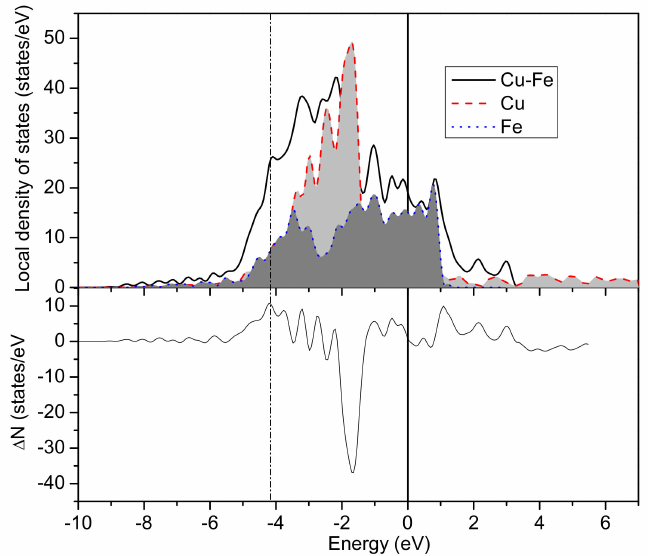
Figure 4. The LDOS of the binary Cu-Fe system, the Fermi energy is set to 0 eV. ∆ N is the di ff erence between the LDOS of Cu / γ –Fe system and that of Cu(100) system and Fe(100) system. For ternary alloy, Cu-Fe-Ag(Si) were taken as an example; the Fe-Cu bonding and antibonding states were determined by the di ff erence ∆ N between the LDOS of the Cu-Ag(Si) / γ –Fe system and that of the Cu-Ag(Si) (100) system and Fe(100) system. The Cu-Ag / γ –Fe interface list in Figure 5 shows that the bonding states were around − 5.45~ − 3.51 eV above the Fermi level and the antibonding states were around 1.69~3.29